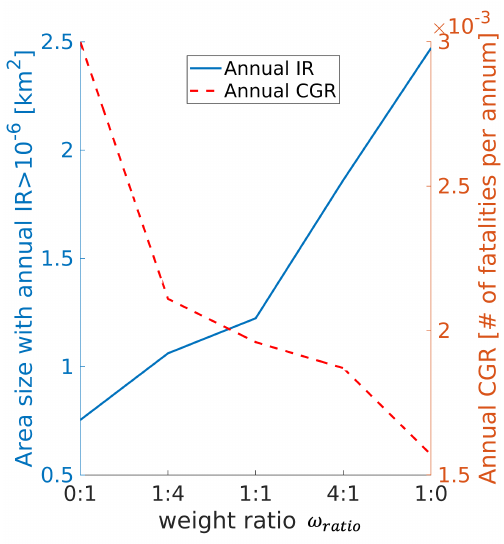
Figure 7. Changes in annual IR and Annual CGR with risk weight